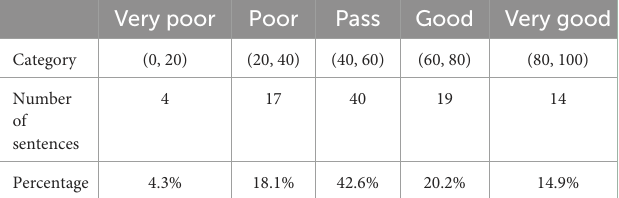
TABLE 3 Overall score distribution in five levels of performance.